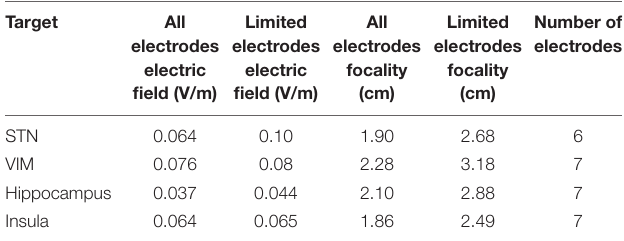
TABLE 2 | The effect of decreasing the number of electrodes on the electric field strength and focality. Target